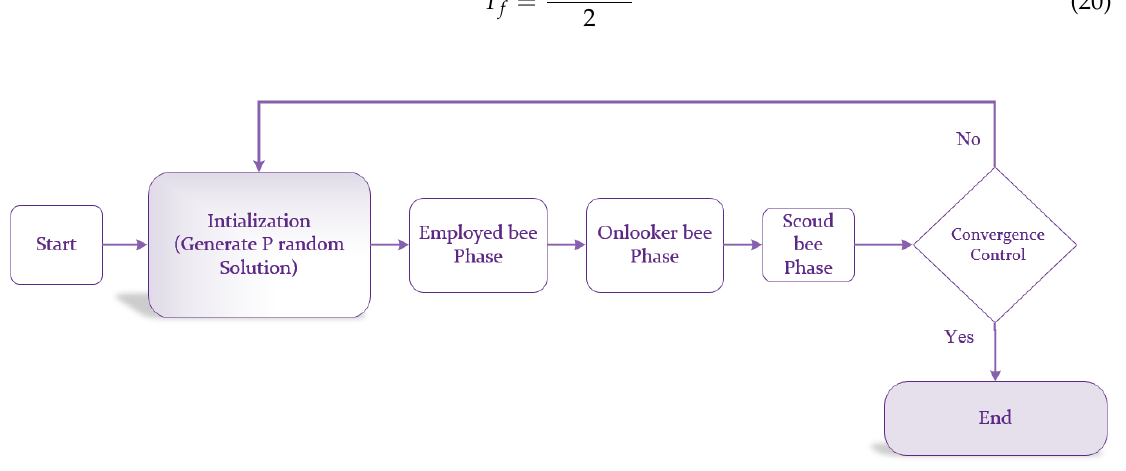
Figure 3. ABC algorithm